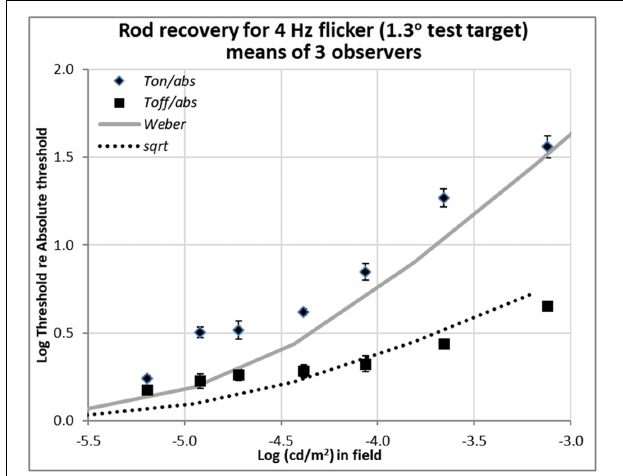
FIGURE 4 | Plots of relative rod thresholds, Ton/Tabs and Toff/Tabs , for perceiving 4 Hz flicker in a larger test target (1.3 ◦ ). Thresholds were averaged over three observers and are plotted as a function of log(cd/m 2 ) in the background field.